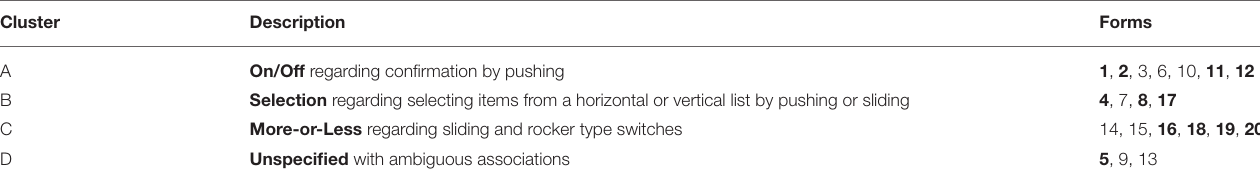
TABLE 2 | Preliminary interpretation of the MDS results as given in Figure 7